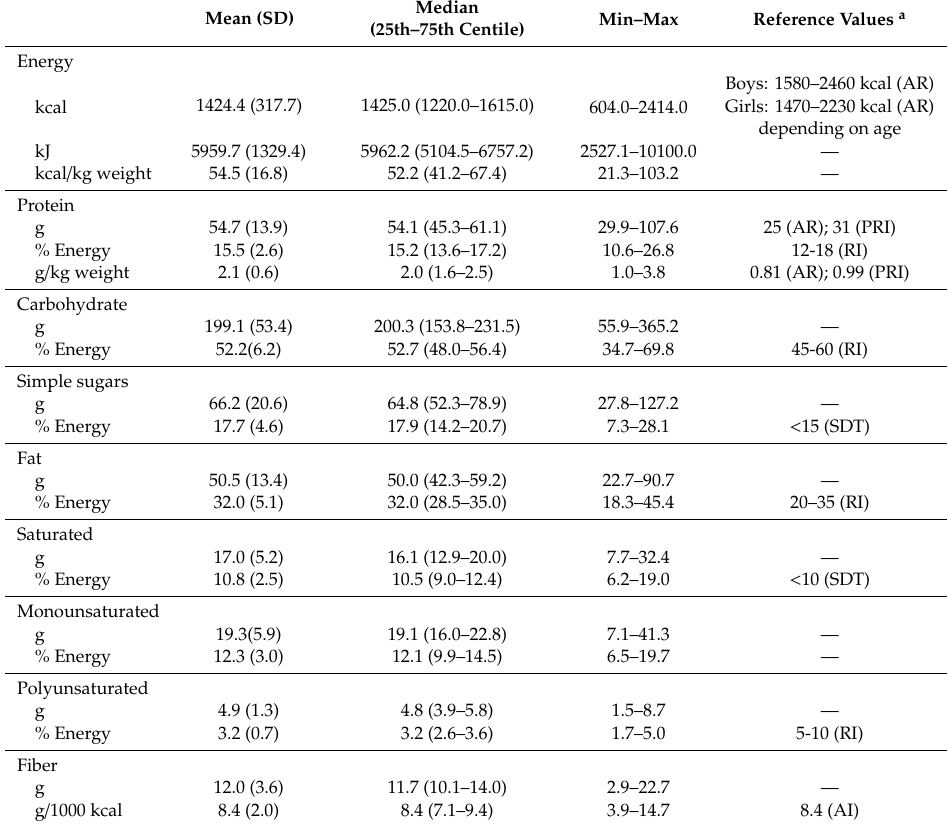
Table 6. Daily dietary intake of energy, macronutrients, and fiber, in children aged 7 ≤ years < 11 ( n =